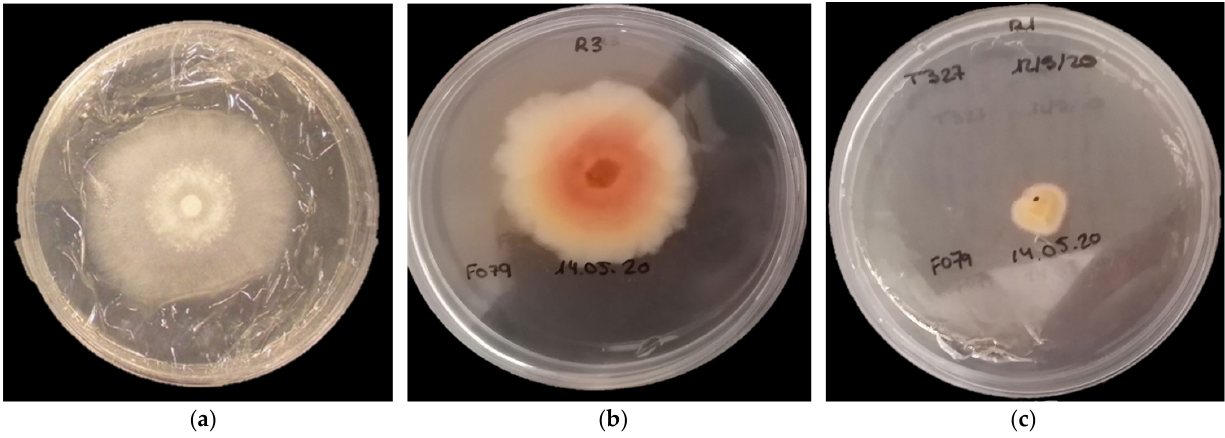
Figure 4. ( a ) Trichoderma spp. growing on the membrane without physical contact to the medium, ( b ) F. sambucinum growing on a negative control on potato-dextrose-agar medium (PDA, Sigma- Aldrich, St. Louis, MO, USA), and ( c ) F. sambucinum growing on PDA after removing the membrane with T. gamsii T327 (74.9% of growth inhibition).